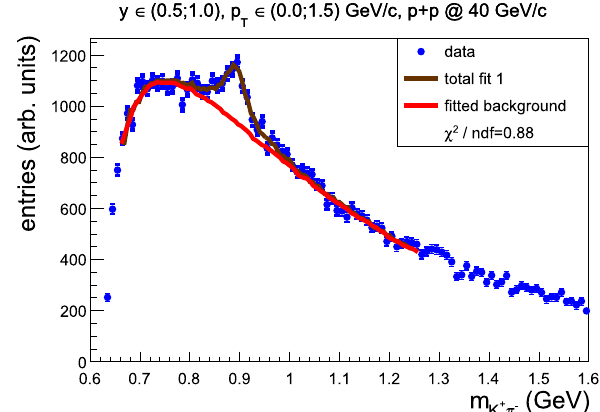
templates. Right: background-subtracted signal – more details in the text. Thin black vertical lines in the right panel correspond to the range